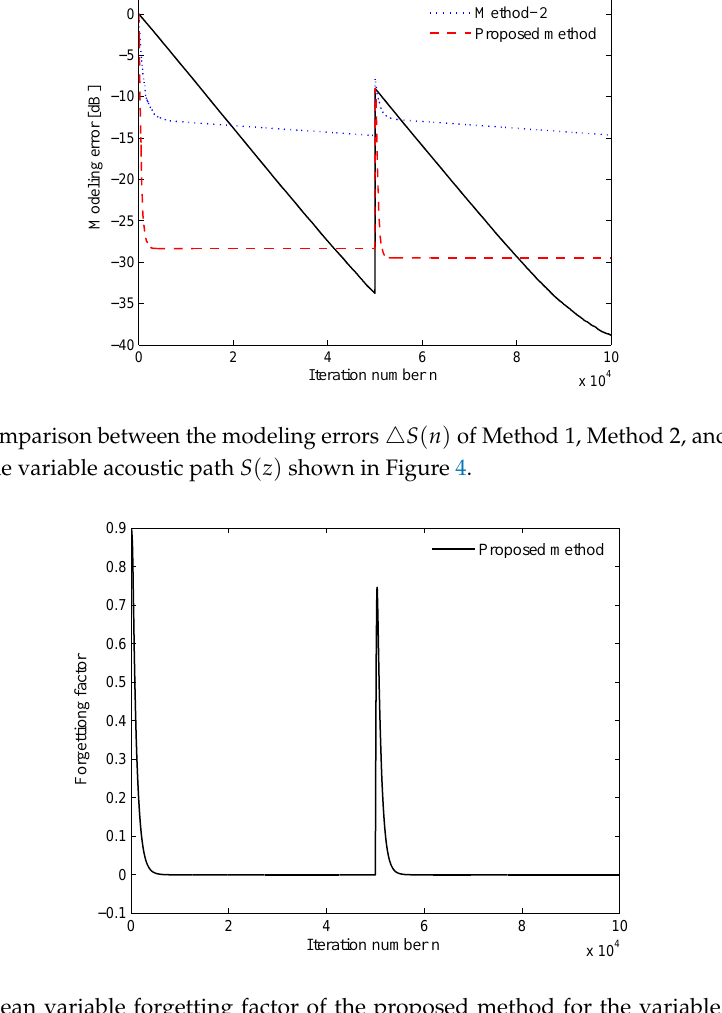
Figure 12. Mean variable forgetting factor of the proposed method for the variable acoustic path S ( z ) shown in Figure